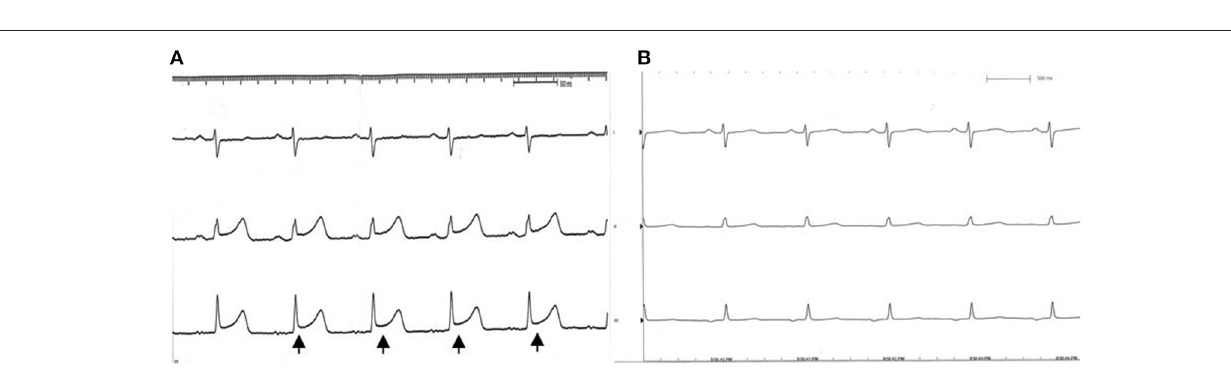
such as ischemic change during interventional